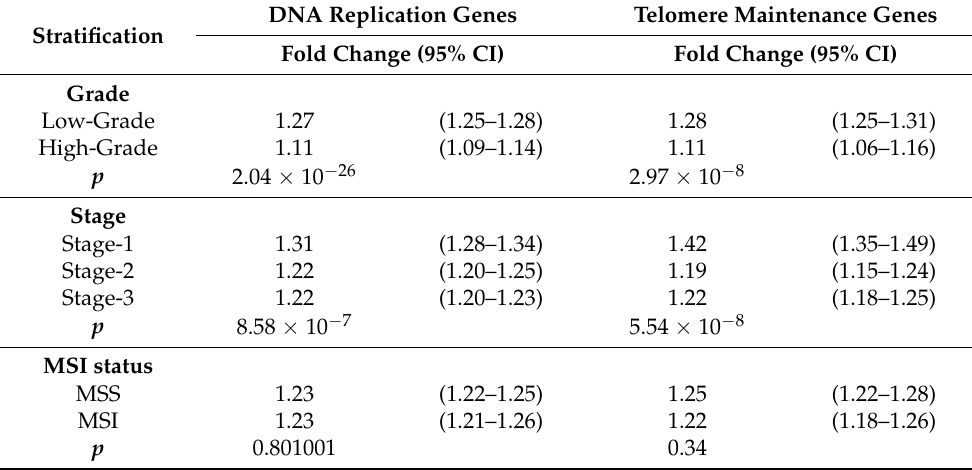
Table 3. Overexpression of DNA replication genes and telomere maintenance genes in CRC compared to paired normal tissue stratified by tumor grade, tumor stage and MSI status. DNA Replication Genes Telomere Maintenance Genes Stratification Fold Change (95% CI) Fold Change (95%